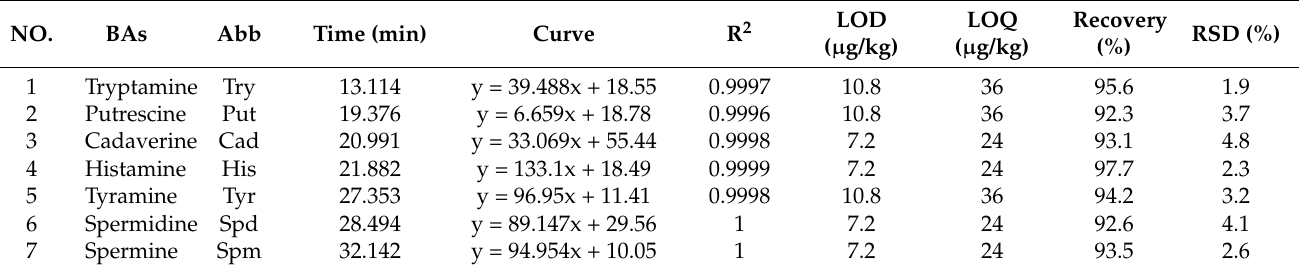
Table 1. Analytical performance of biogenic amines by